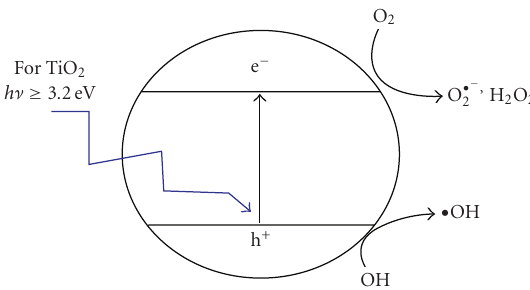
For TiO 2 h ν ≥ 3 . 2eV